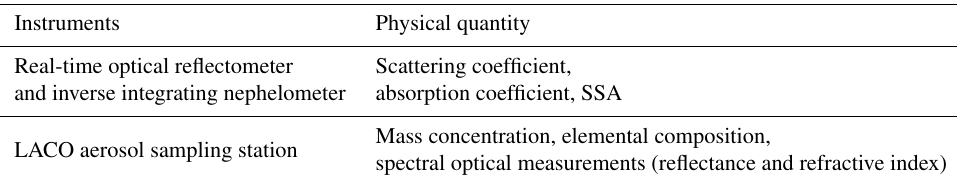
Table 2. Quantities derived from real-time ground-based in situ measurements and laboratory analysis of in situ filter collection of Saharan dust samples during the Fennec